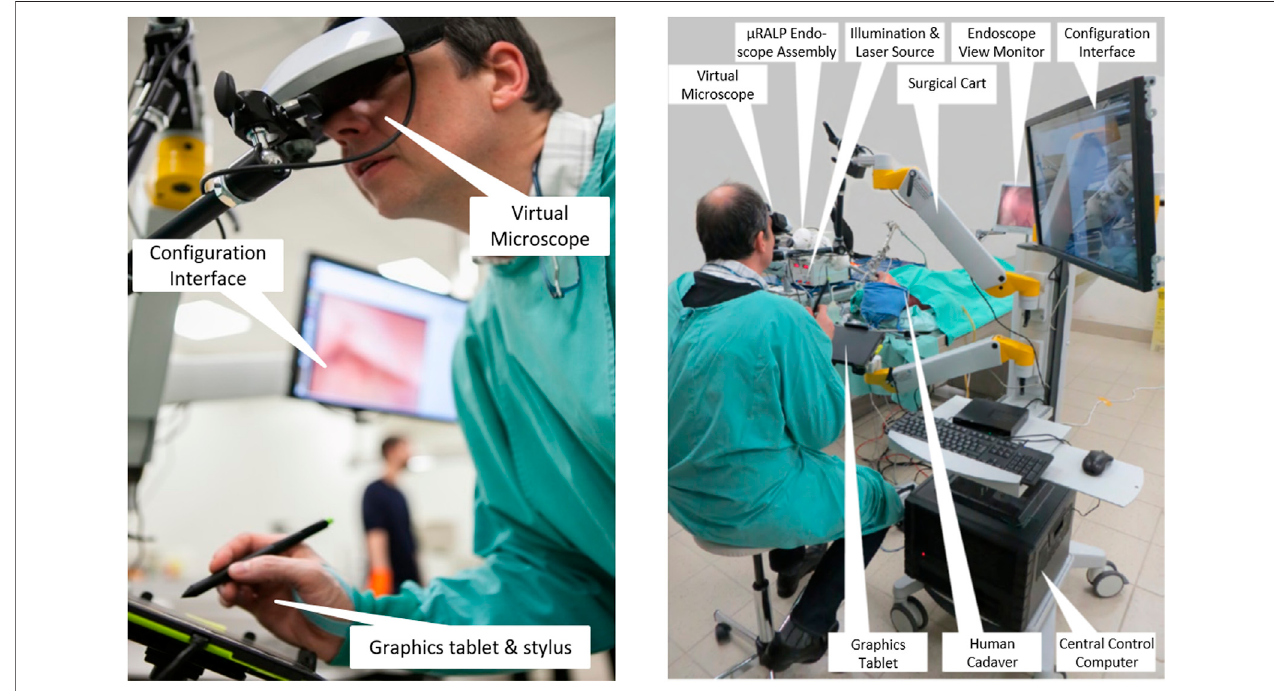
FIGURE 8 | The µRALP teleoperation interface and its components (Deshpande et al., 2014).